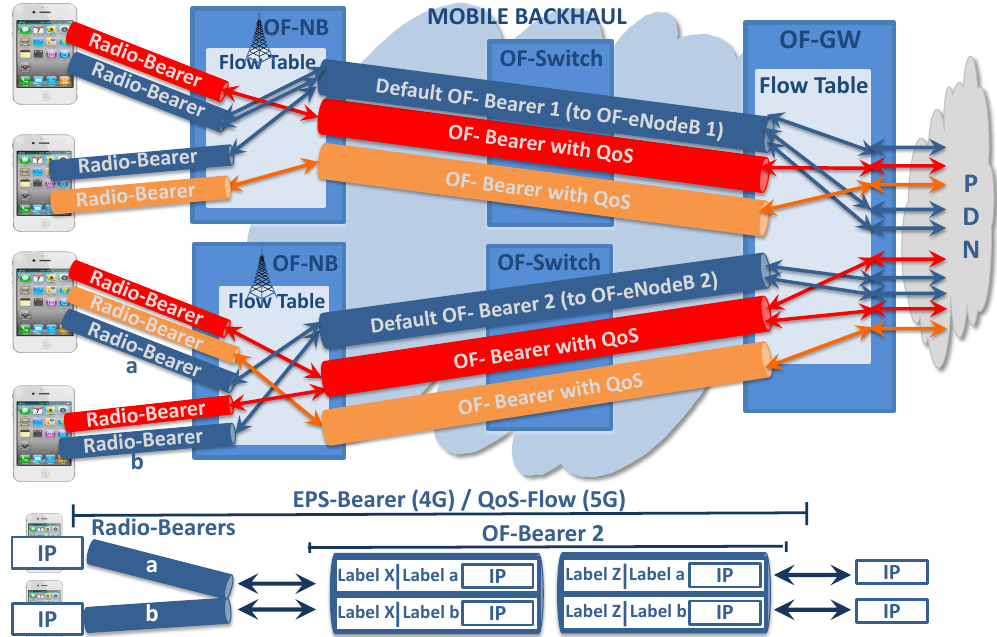
Figure 3. Representation of: MPLS label, EPS-Bearer, Radio Bearer, and